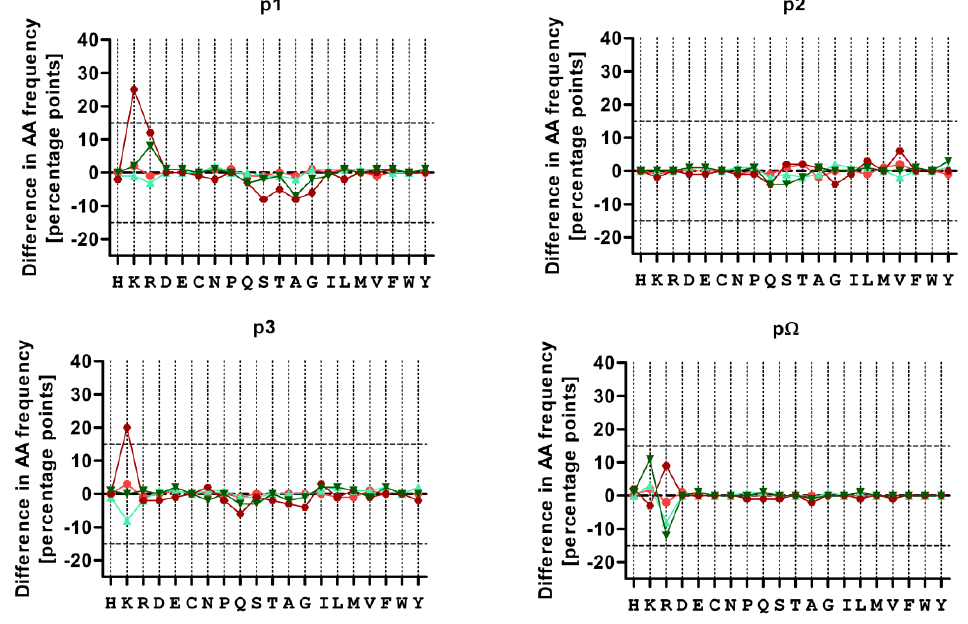
Figure 3. Incubation with carbamazepine (CBZ) provokes a shift in high binding peptides bound to sA*31:01. Changes in AA frequencies of sA*31:01-bound peptides at p1, p2, p3 and p Ω are displayed after treatment with either CBZ (red) or 11-epoxide (EPX) (green) for low binding peptides (bright colors) and high binding peptides (dark colors).